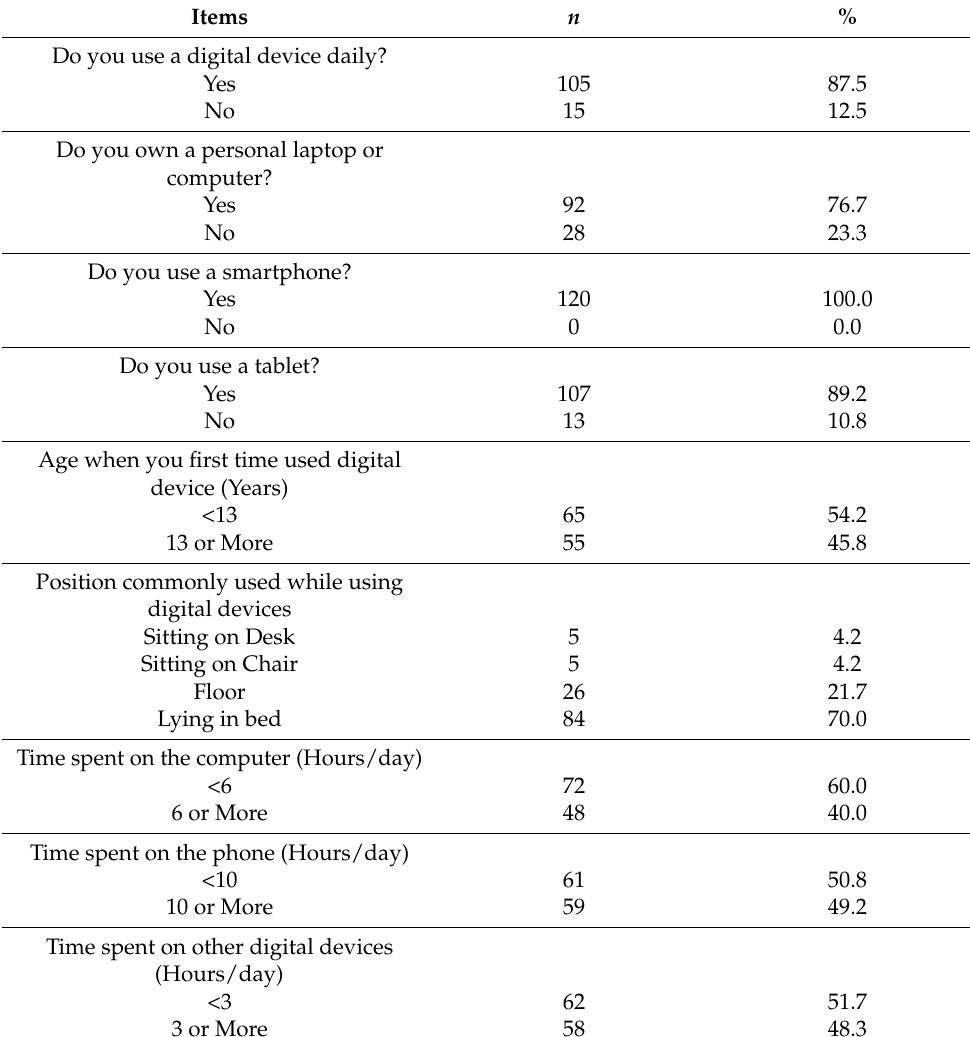
Table 3. Number and distribution of digital devices usage and spent